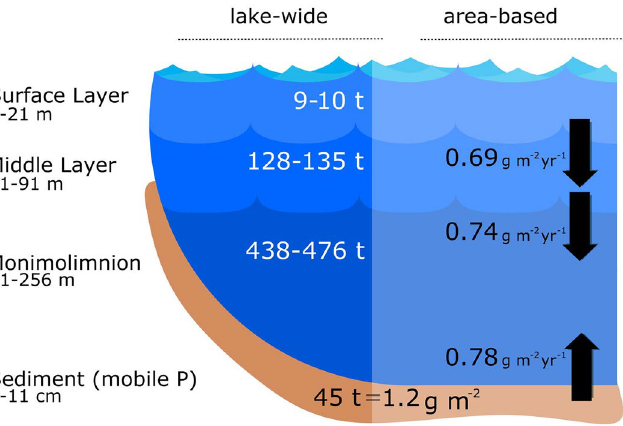
Figure 5. Pools (ranges of 2017) and fluxes (April 2016–April 2017) of total phosphorus (TP) in Lake Iseo. Lake-scale pools are expressed in metric tons (t) of P, and fluxes (right, in g P m −2 year −1 ) represent yearly averages. Potentially mobile P (“gradient method”) in the monimolimnetic sediment is expressed both as total and per area. Additional information can be found in Table